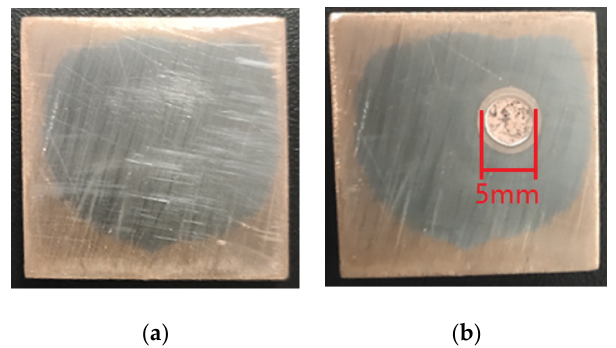
Figure 5. Area scan results of the transition layer of steel side. ( a ) scan area, ( b ) distribution of Cu, and ( c ) distribution of Fe.